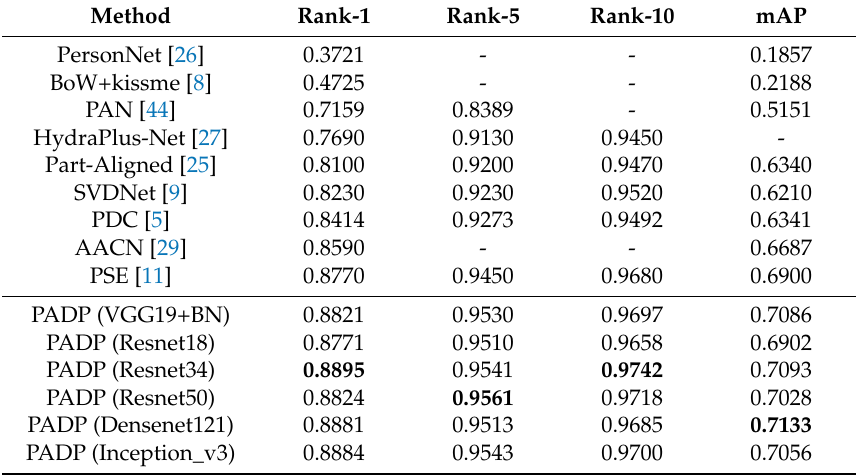
Table 3. Rank-1, rank-5, rank-10 and mAP of various methods on the Market-1501 dataset.